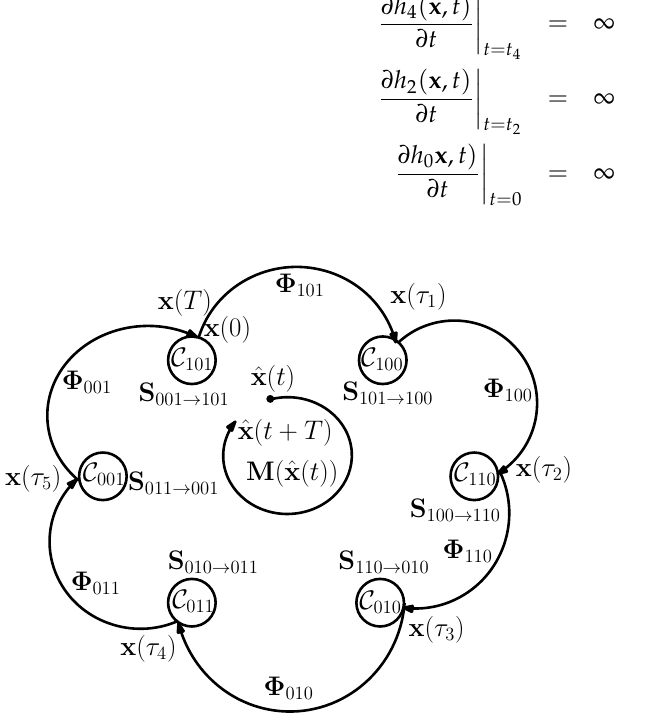
Figure 7. Transition state diagram between the different configurations and their corresponding